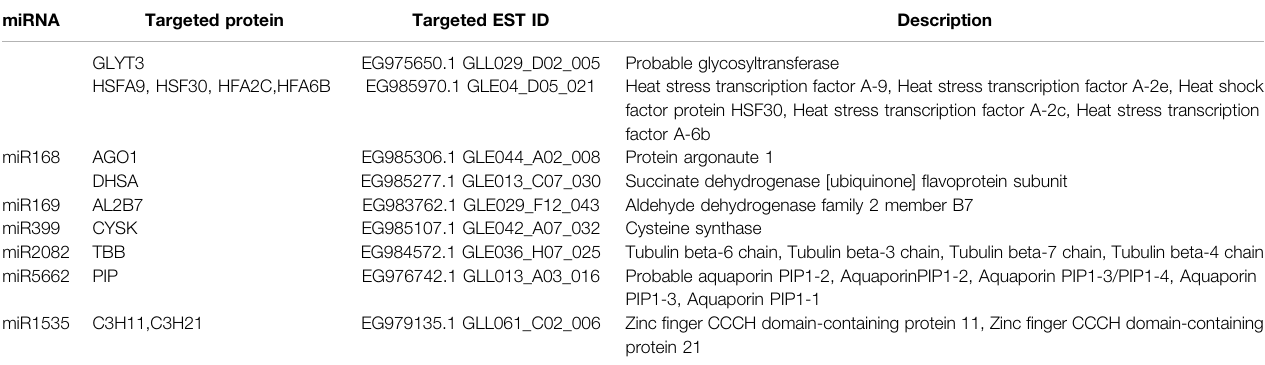
TABLE 2 | ( Continued ) Major potential target genes for predicted miRNAs in cluster bean. miRNA